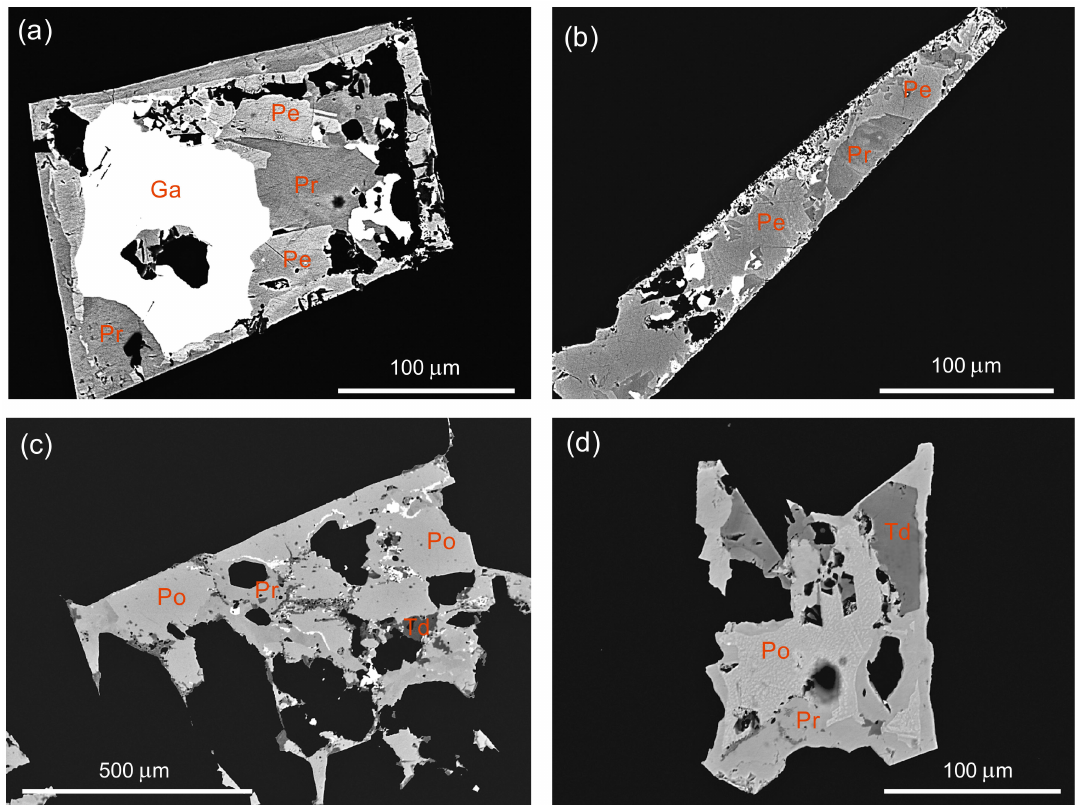
Figure 17. ( a ) Se-rich pearceite (Pe) associated with galena (Ga) and proustite (Pr); ( b ) pearceite (Pe) overgrown with proustite (Pr); ( c ) polybasite (Po) associated with proustite (Pr) and Ag-rich tetrahedrite (Td); ( d ) polybasite (Po) in association with proustite (Pr) and Ag-rich tetrahedrite (Td); all back-scattered electron (BSE)